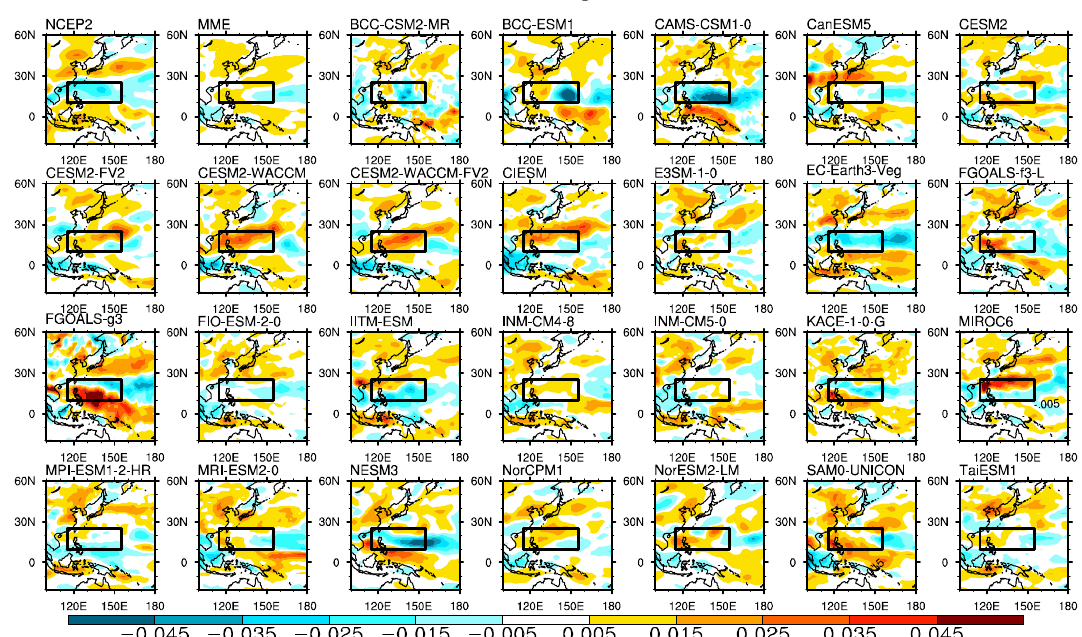
Atmosphere 2021 , 12 , 664 Figure 9. The same as Figure 7, but for the vertical velocity at 500-hPa (units: Pa/s).